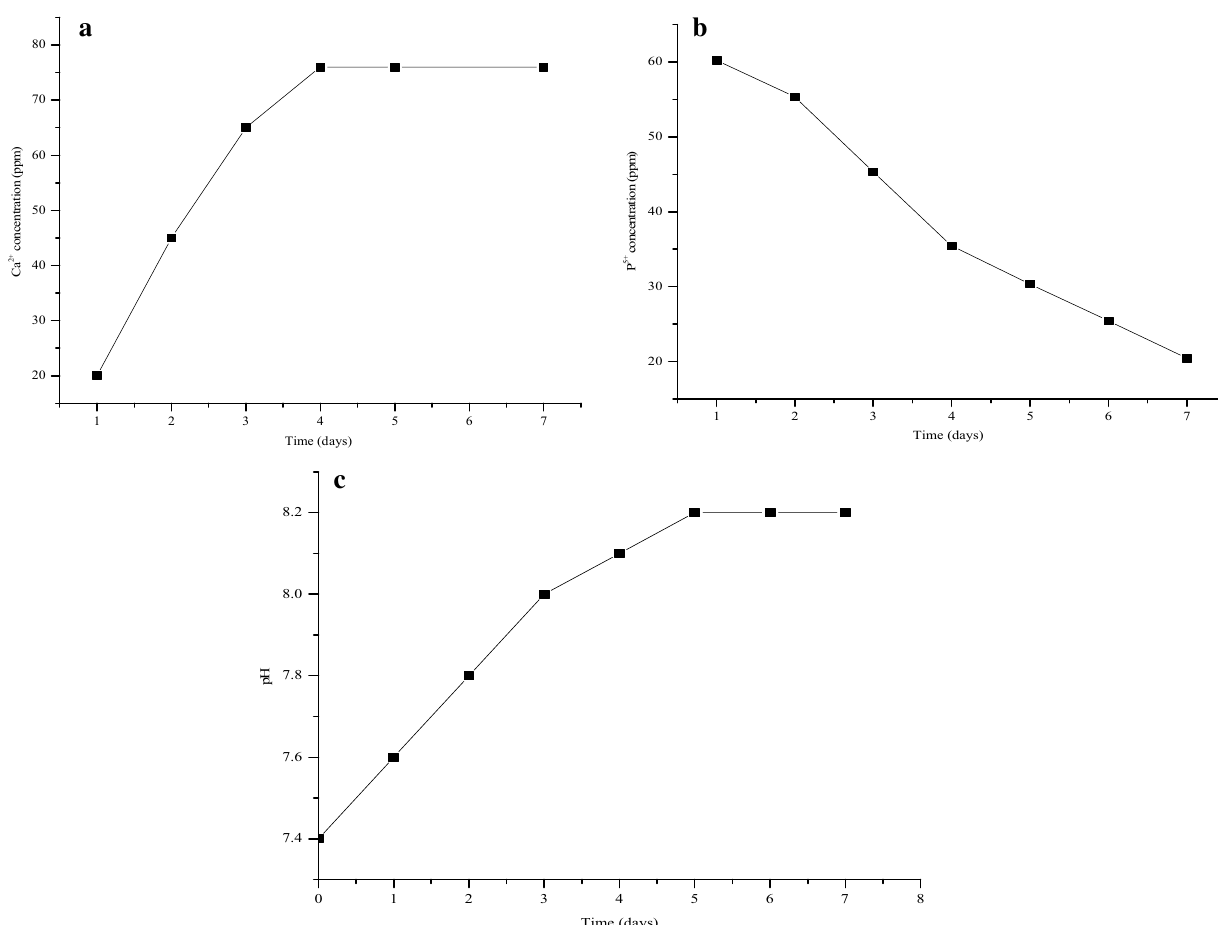
Fig. 12 Concentrations of a Ca 2+ , b P 5+ and c pH of SBF solution after 7 days of immersion in SBF 7.4 and temperature of 37 °C